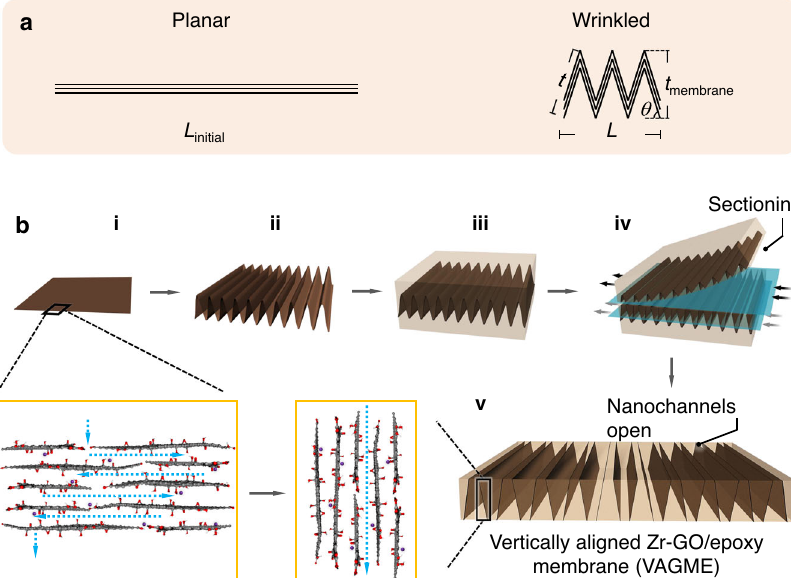
Fig. 1 Structure and fabrication steps leading to vertically aligned Zr-GO/epoxy membranes. a Sketch of compressive fi lm wrinkling. Side view of planar and 1D wrinkled fi lms. Figure illustrates that wrinkling tilts the horizontal line into multiple near vertical line segments. b Fabrication steps leading to vertically aligned Zr-GO/epoxy membranes. i , Drying-induced assembly of Zr-GO nanosheets (Zr/C atomic ratio approximately 1/22) on pre-stretched polystyrene substrate (GO fi lm thickness 1 μ m). Inset: nanostructure of planar Zr-GO fi lms with horizontal alignment and tortuous fl ow pathways. Brown strips represent 1 μ m thick multilayer GO fi lm segments. The light-yellow box represents the epoxy matrix. Purple spheres represent ZrO(II) cations (unhydrated state for reference). Fully hydrated ZrO(II) diameter is approximately 1 nm, implying that ZrO(II) likely exists in the interlayer spaces in a partially hydrated state complexed with O-containing groups on GO. ii , Wrinkled Zr-GO fi lms are produced by thermally activated mechanical compression. iii , Wrinkled Zr-GO fi lms are removed from the substrate and imbedded into epoxy resin. iv , Multiple cycles of microtome sectioning yield Zr-GO/epoxy composite membranes. v , Side view of vertically aligned Zr-GO/epoxy membrane (VAGME) with the entrances to interlayer nanochannels open at the top and bottom surface. This method transforms a single planar Zr-GO fi lm into hundreds of vertical fi lm segments, where each segment is an array of approximately 1000 GO interlayer nanochannels aligned with a strong Z-directional